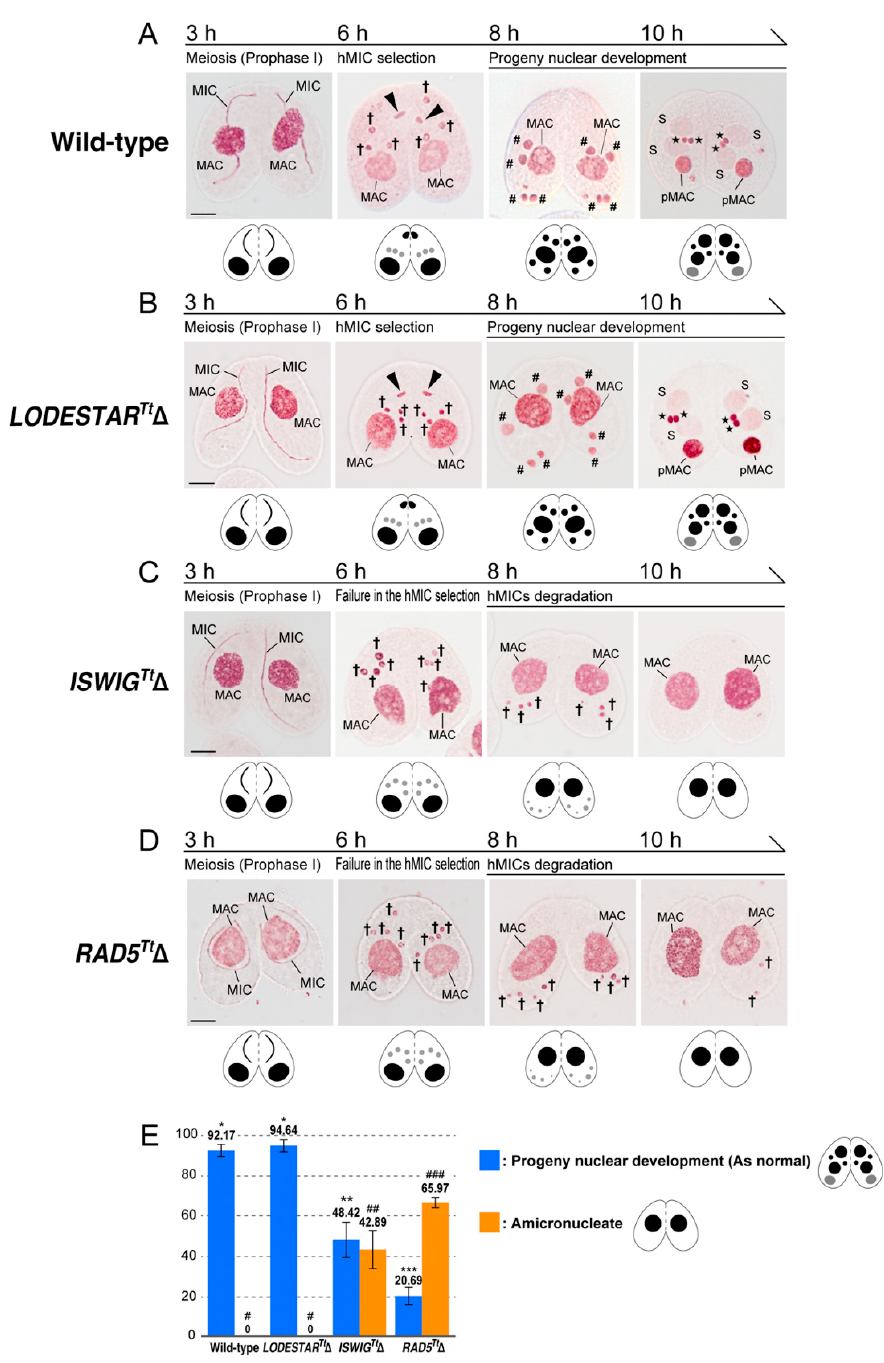
Figure 3. Knockout of the Snf2 family proteins which appear in the selected hMIC on conjugation. ( A ) acetic orcein staining of the wild-type pairs. Because acetic orcein stains DNA, nuclei are visualized under light microscopic observation; ( B ) acetic orcein staining of the LODESTAR Tt ∆ pairs; ( C ) acetic orcein staining of the ISWIG Tt ∆ pairs; ( D ) acetic orcein staining of the RAD5 Tt ∆ pairs. Schematic diagrams of nuclear behavior are shown below each micrograph. Triangle—the selected hMIC; †—unselected hMIC; #—zygotic nuclei undergoing post-zygotic nuclear divisions; S-progeny MAC Anlagen; star-progeny MIC; pMAC-degrading parental MAC. The scale bar denotes 10 µ m; ( E ) percentage of pairs showing progeny nuclear development and amicronucleate phenotype at 10 h. Columns represent means. Difference in the number of symbols (asterisk-* and sharp-#) indicates a statistically significant difference ( p > 0.01, One-way ANOVA with post-hoc Tukey HSD test).